Question: State the chart type depicted above.
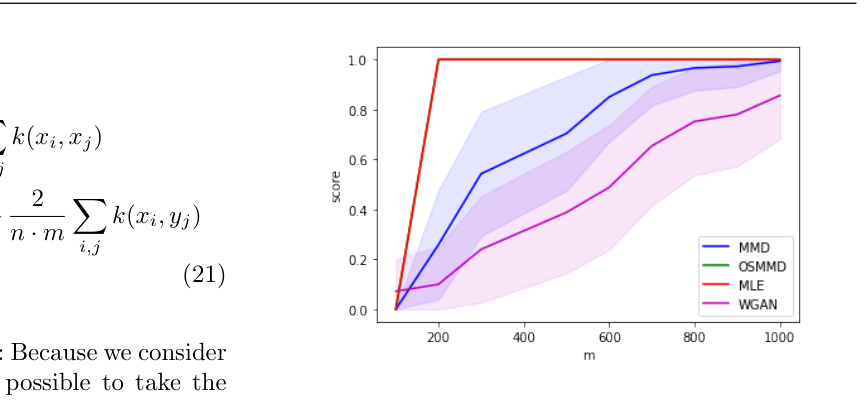
Answer: line